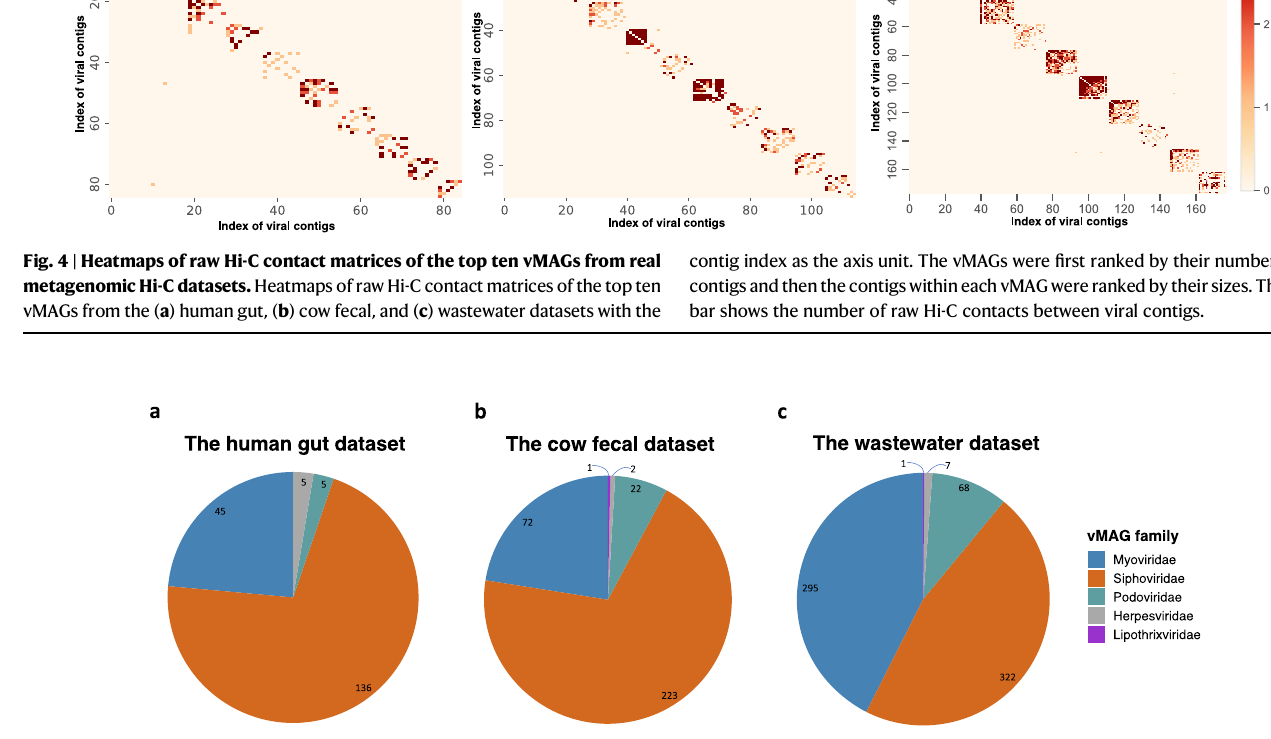
of vMAGs belonging to different families. Source data are provided as a Source Data fi le.